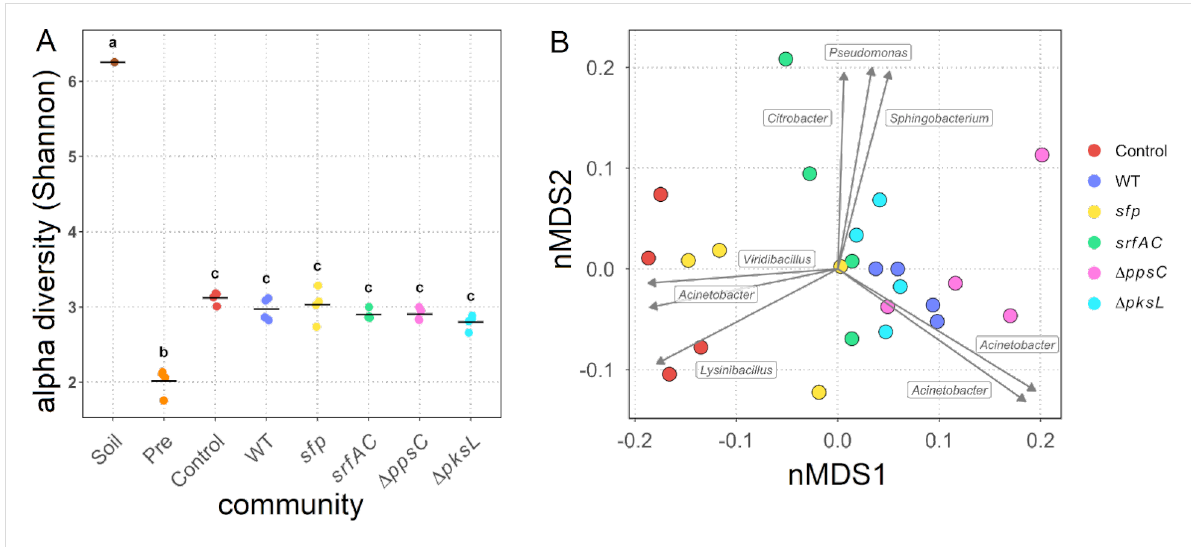
Figure 4: Diversity analyses of the soil sample (“Soil”), 12 h preincubated soil suspensions (“Pre”), and untreated (“Control”) or treated mock commu- nities with either B. subtilis wild type (“WT”), the NRP-deficient strain sfp , the surfactin mutant srfAC , the plipastatin mutant ∆ ppsC , or the bacillaene mutant ∆ pksL , cocultivated for 48 h. A) Alpha diversity (in Shannon) of the different samples. Each point represents a replicate, while the line indi- cates the mean of the Shannon diversity indexes. B) Beta diversity of the mock communities calculated with the Bray–Curtis dissimilarity and visu- alised as circles in a nMDS. The vectors, each labelled with the corresponding genus, represent the ASVs, with the highest correlating with the nMDS ordination. The vector lengths are proportional to the level of